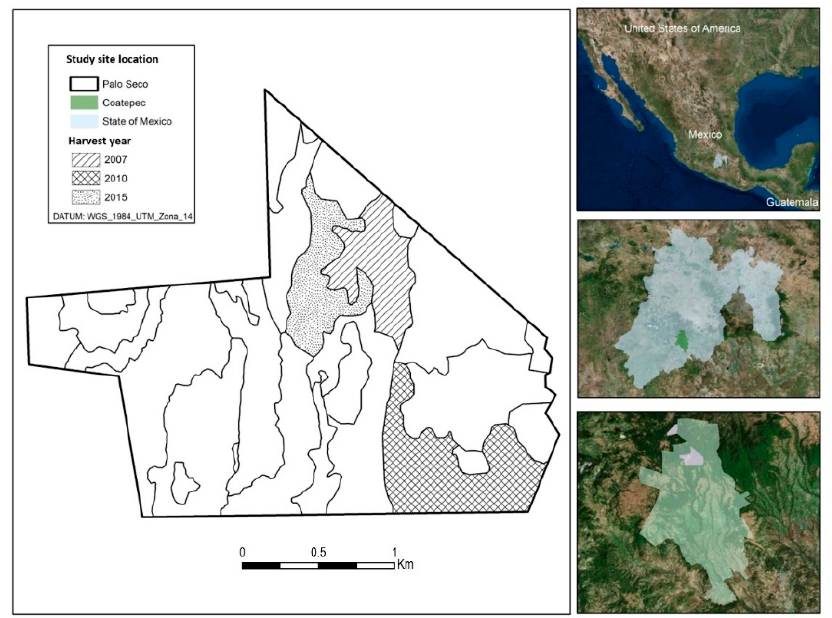
Figure 1. Study area—Ejido Palo Seco, Coatepec Harinas in the state of Mexico and map of harvested areas in 2007, 2010 and 2015.